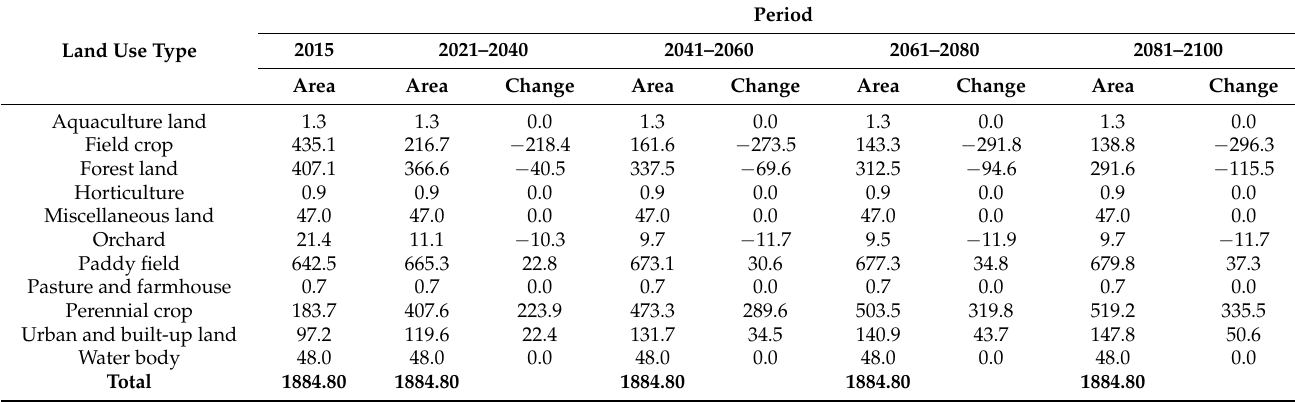
Table 3. Changes in future land use patterns compared to the year 2015.